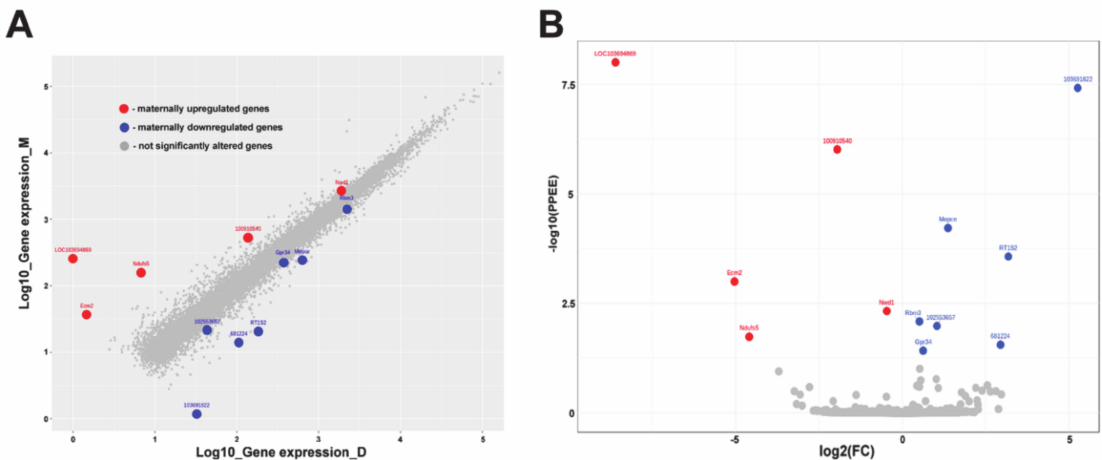
Figure 2. Representation of the expressional changes of the genes. ( A ) Scatter plot of the expressed genes in preoptic samples of mother (M) and pup-deprived controls (D). ( B ) Volcano plot shows the significance values and the fold change values to highlight the differentially expressed genes. Red dots represent maternally elevated, while blues represent maternally decreased differentially expressed genes. Genes without significant change are grey.